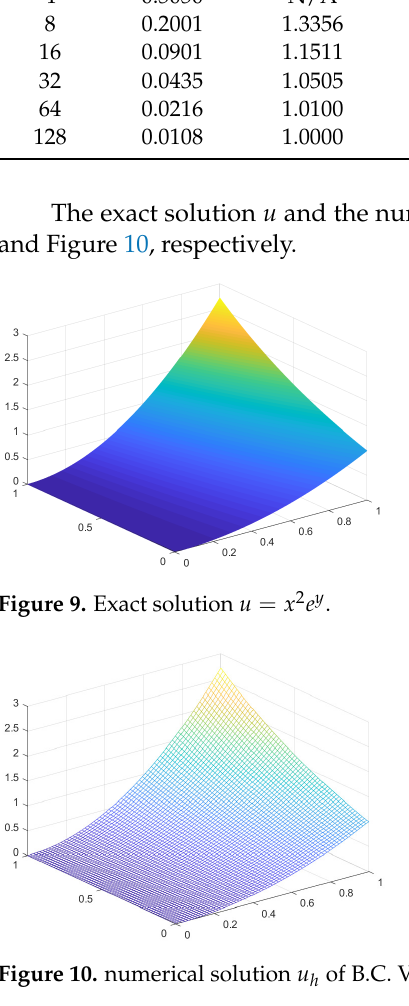
Figure 9. exact solution u = x 2 e y Figure 10. numerical solution u h of B.C. V Figure 10. numerical solution u h of B.C.